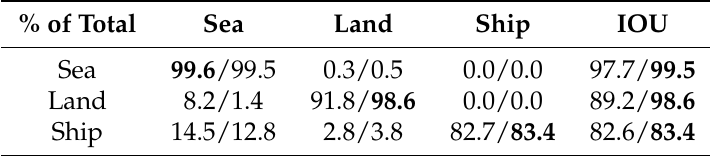
Table 8. Accuracy of segmentation with or without multi-scale. Confusion matrix with percentages row-normalized and IOU for each class. a network without/with multi-scale on GaoFen-1 images.